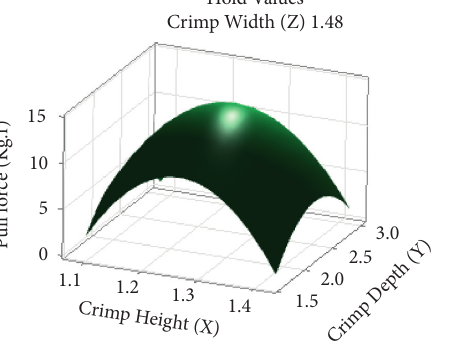
Figure 6: Surface plot of pull force versus crimp depth ( Y ) and crimp height ( X ).